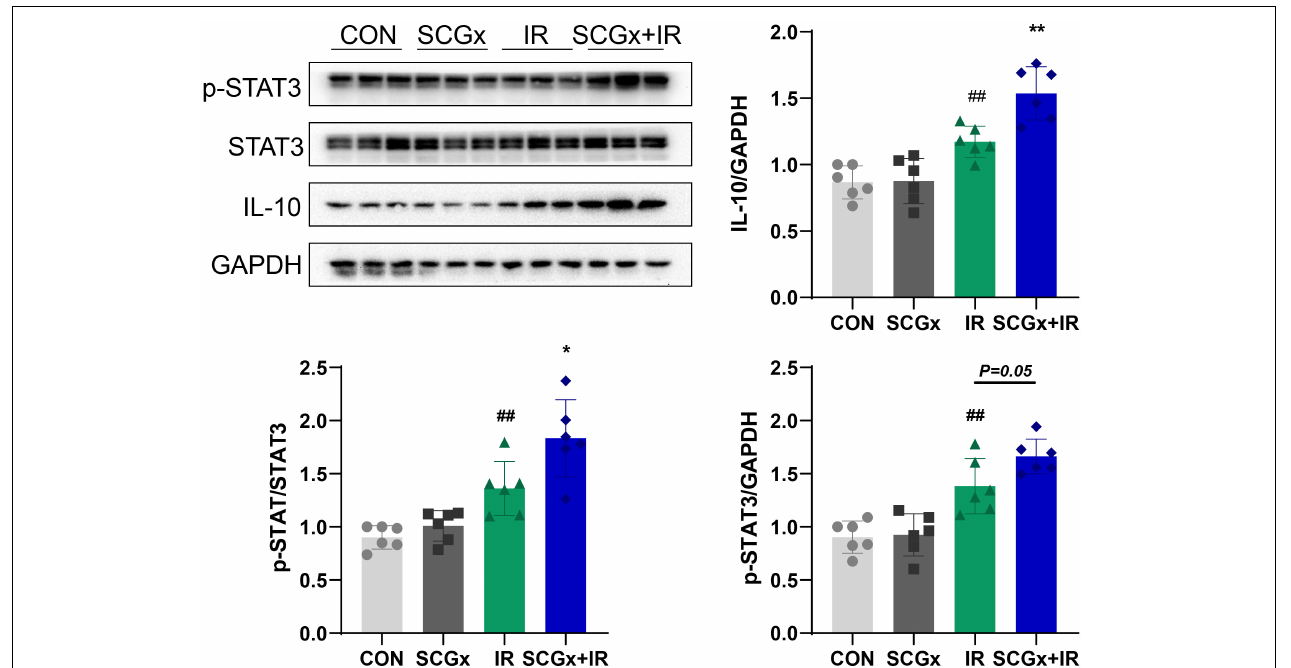
FIGURE 5 | Sympathetic denervation activates the p -STAT3 signal in mice with myocardial I/R injury. The expression of IL-10 and p -STAT3 in heart tissue. n = 6, * P < 0.05 and 0.001 < ** P < 0.01 compared with the I/R group. 0.001 < ## P < 0.01 compared with the CON